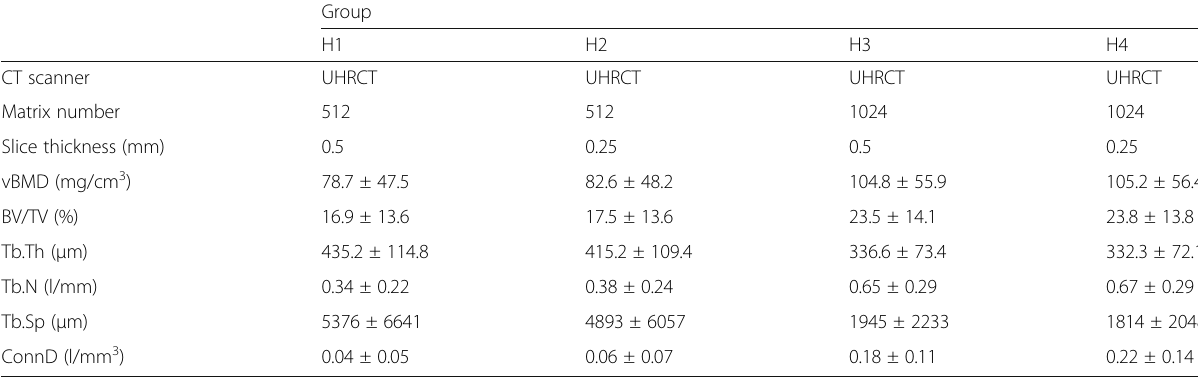
Table 4 Comparison of human tibial microarchitectural parameters on UHRCT with different matrix numbers and slice thicknesses in vivo